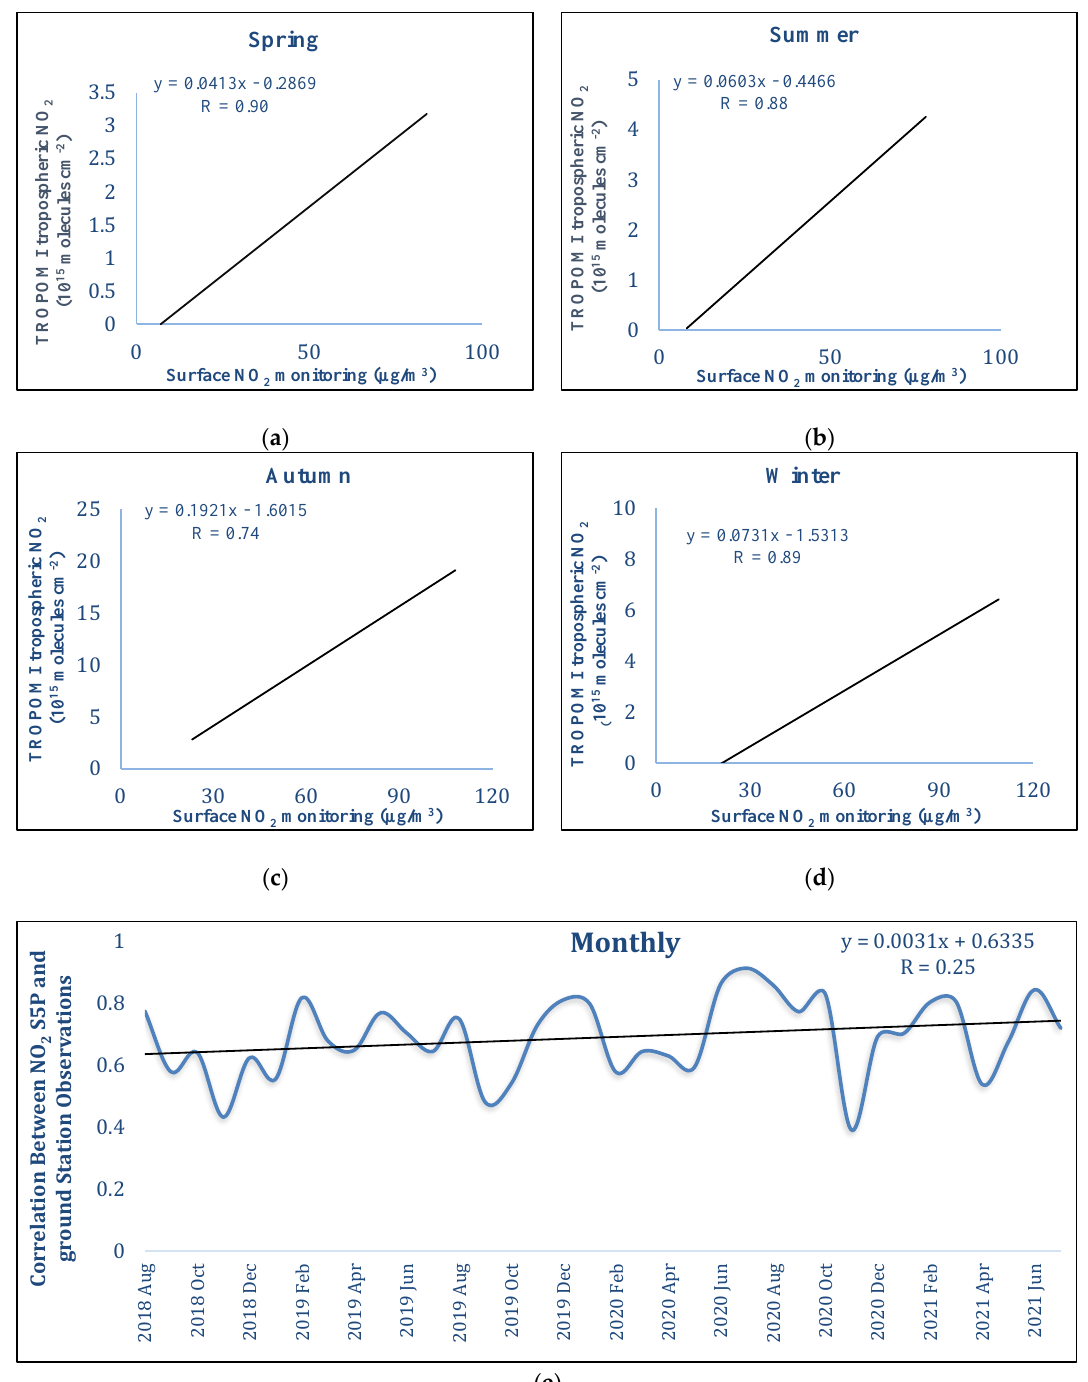
Figure 4. The regression between ground NO 2 data (µg/m 3 ) and TROPOMI tropospheric NO 2 column concentration (10 15 molecules cm −2 ) at different times of the year. ( a ) Spring. ( b ) Summer. ( c ) Autumn. ( d ) Winter. ( e ) monthly scale (black line in the chart is the trend line for NO 2 ).